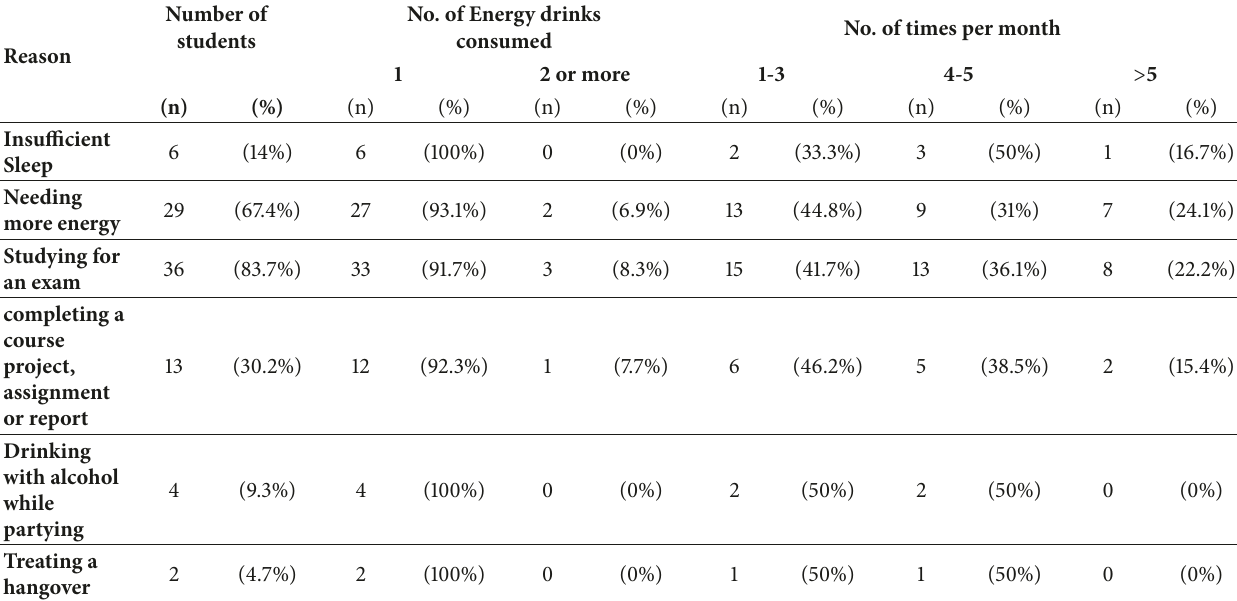
Table 4: Reasons given by students for taking energy drinks and the number of energy drinks taken (n =